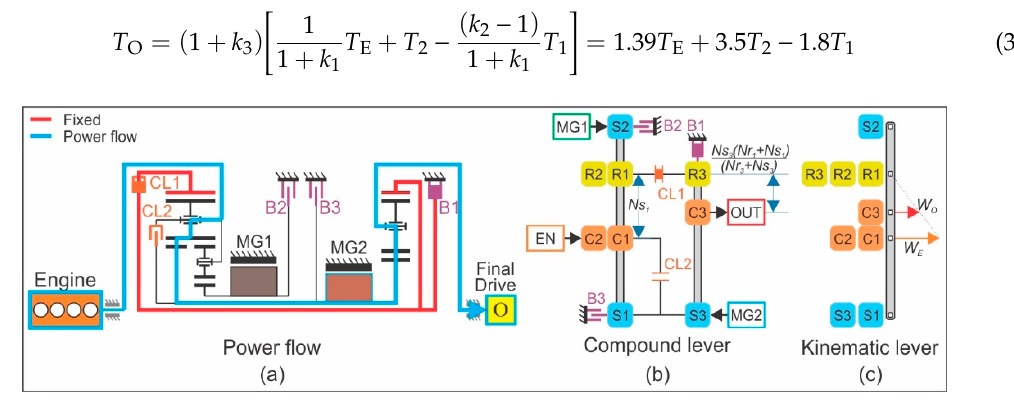
Figure 22. Third fixed gear.